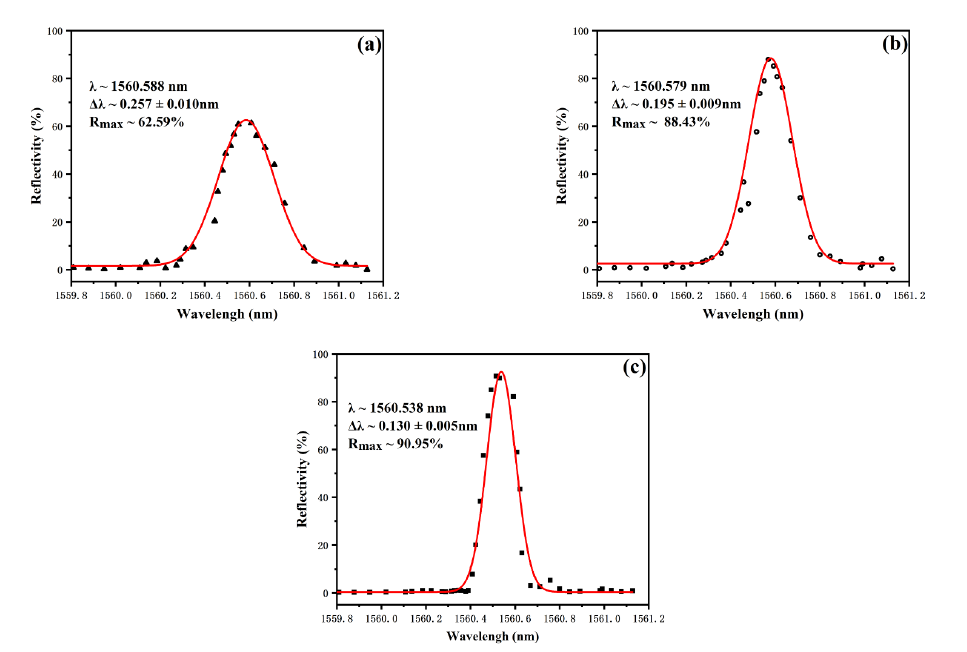
Figure 6. Test results of three FBGs with different bandwidth. ( a ) The result of the FBG with 0.257 nm bandwidth. Its reflectivity is 62.59%. ( b ) The result of the FBG with 0.195 nm bandwidth. Its reflectivity is 88.43%. ( c ) The result of the FBG with 0.130 nm bandwidth. Its reflectivity is